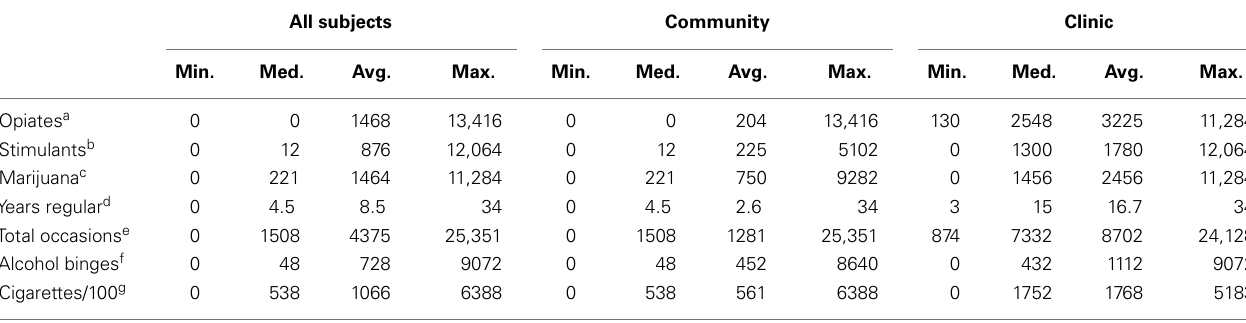
Table 1 | Frequency of drug use .